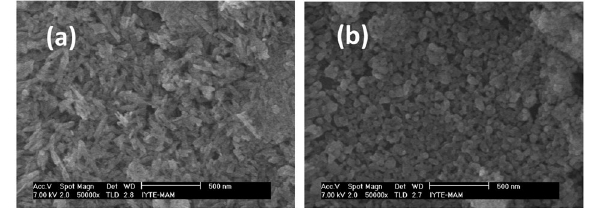
Fig. 2 The SEM images of the thin fi lms prepared with 15w% HAp suspensions after the heat treatment at 560 °C, for 30 min. with a heating rate of 15 °C/min at various magni fi cations ( a ) c-HAp 50,000x, ( b ) m-HAp 50,000x.